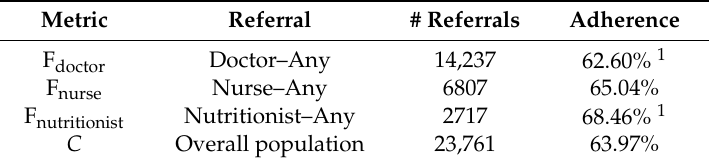
Table 1. Adherence to grouped referrals from one particular discipline to any other discipline.